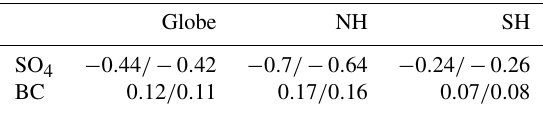
Table 2. Simulated changes in annual and JJA mean sea surface temperatures caused by SO 4 and BC averaged over globe, Northern Hemisphere (NH), and Southern Hemisphere (SH; unit: